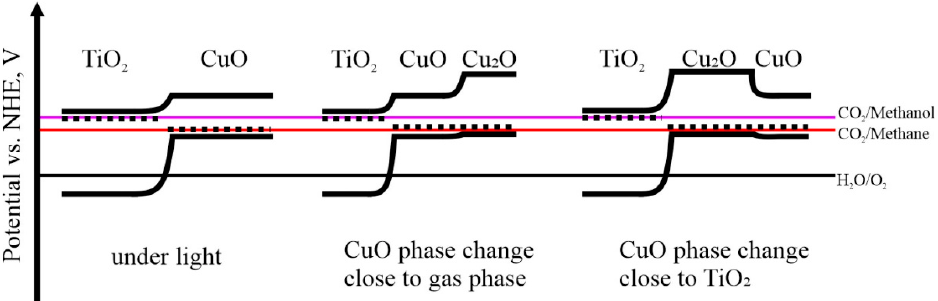
Figure 6. Energy band bending model in NTs/CuO-Cu 2 O composites.